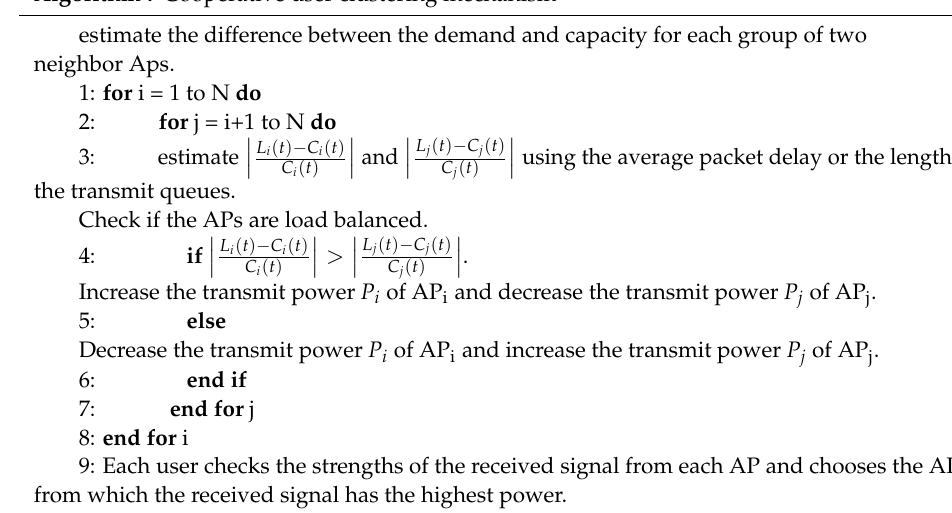
Algorithm 7 Cooperative user clustering mechanism